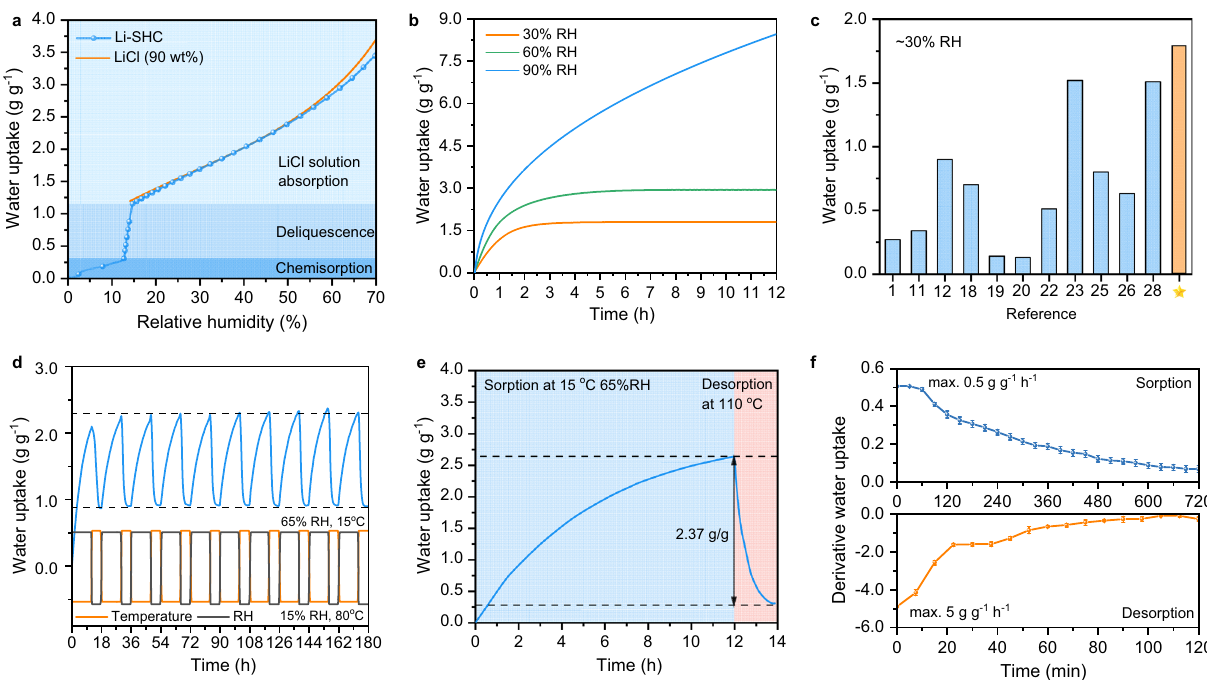
e Dynamicsorption and desorptioncurvesof 2-mm-thickbulkLi-SHCsample. The sorption curve was measured under a simulated semi-arid climate with the slight wind (15°C, 65% RH). The desorption curve was measured using a hot plate at 110°C. f Derivative water uptake changes of 2-mm-thick bulk Li-SHC sample demonstrating the mismatch between sorption and desorption time. Error bar: standard deviation